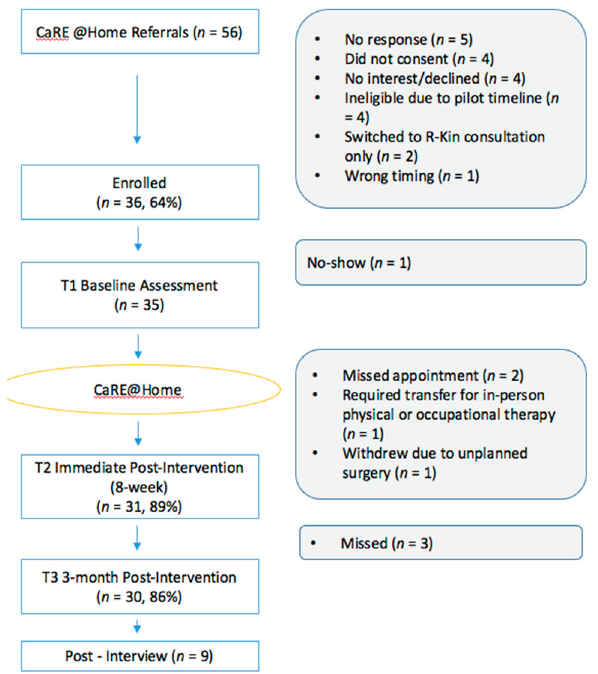
Figure 1. Program flow.